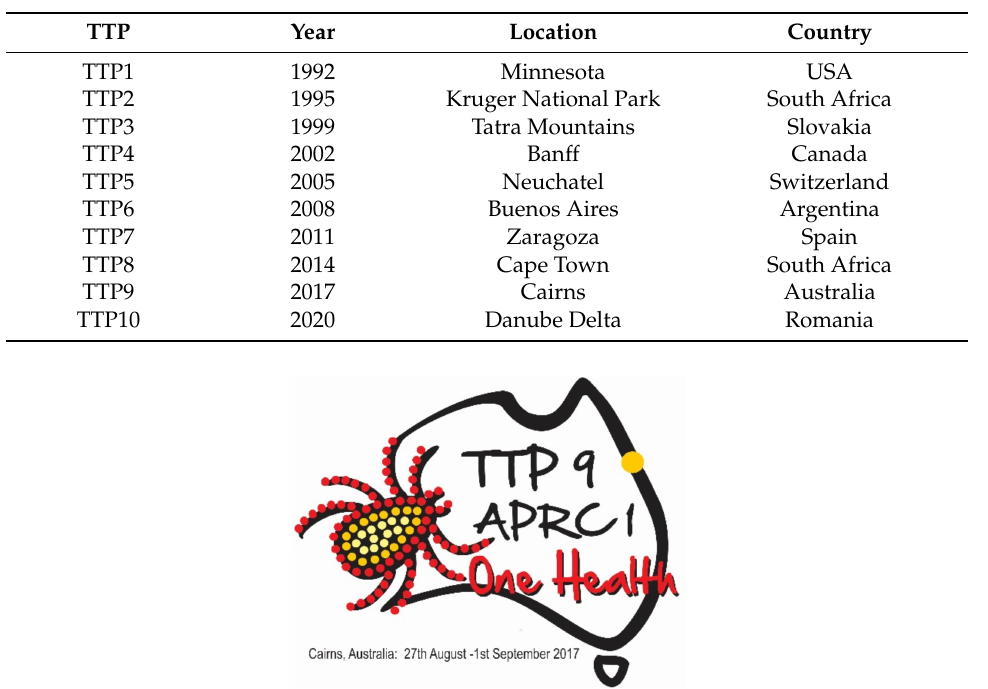
Table 1. List of Tick and Tick-borne Pathogen conferences.